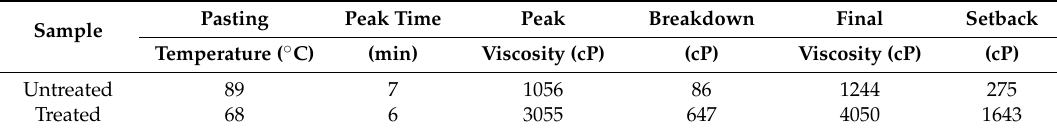
Table 4. Viscosity parameters of untreated and alkali-treated defatted rambutan seed flours. Sample